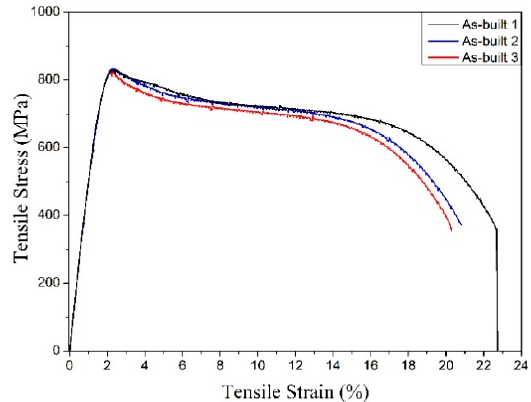
Figure 6. Stress–strain curves of the β -Ti21S produced by L-PBF under tensile loading along the z-direction.